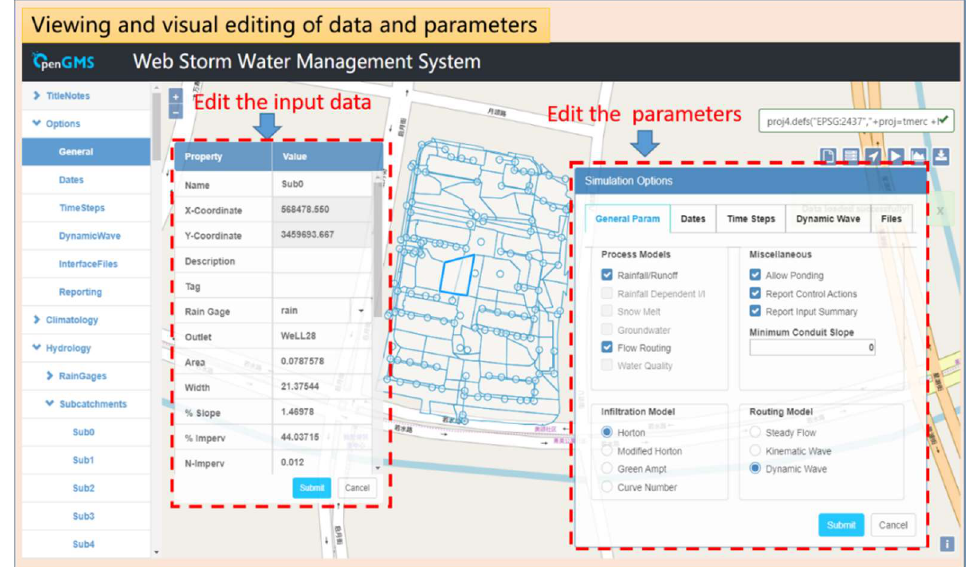
Figure 18. Viewing and visual editing of data and parameters.